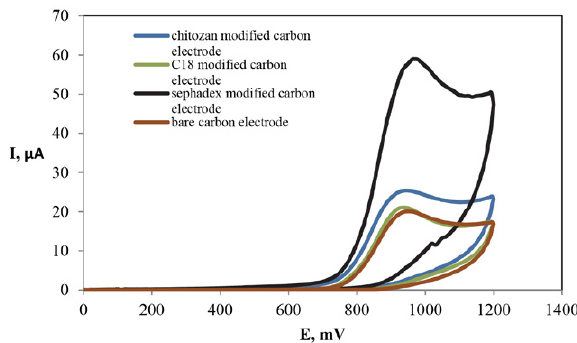
Figure 4. Cyclic voltammograms of 1.0 mM SLC in PH 7.0 using different modified and unmodified electrodes.